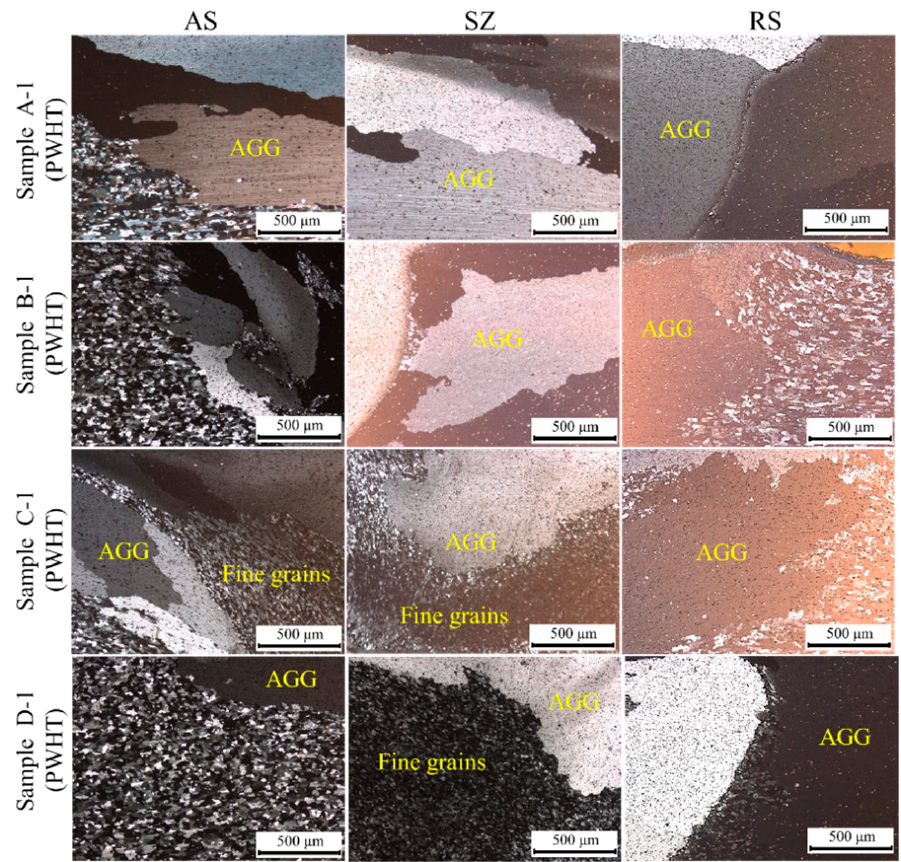
Figure 5. AGG occurs in the microstructure of PWHTed Al5083-l6061 (T6) at a constant travel speed of 100 mm/min.